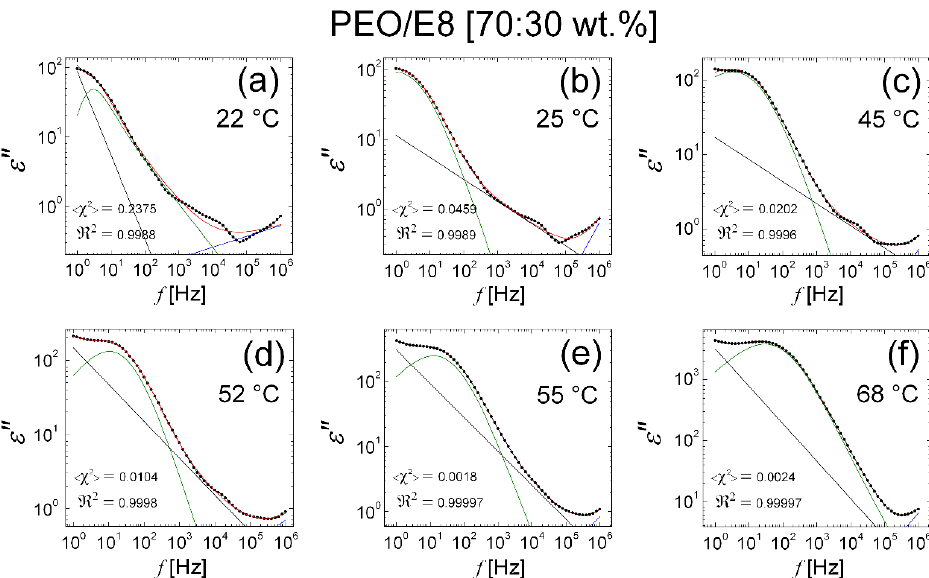
Figure 19. Fits on ε ″ ( f ) spectra for PEO/E8 using Equation (3). The ε ″( f ) spectra correspond to temperature range of 22 °C to 68 °C: 22 °C ( a ); 25 °C ( b ); 45 °C ( c ); 52 °C ( d ); 55 °C ( e ); 68 °C ( f ). The ε ″ spectral data are represented by the symbol (X); the blue and the green lines of the best fits on the ε ″ data are the contributions of the two HN functions in the term; the straight line represents the contribution of the conductivity term; the envelope of the three spectral components’ curves (the total fit) is colored in red. The values of the reduced < χ 2 > factor (the coefficient of determination of fit), as well as the regression coefficient (the goodness of fit), are also shown.